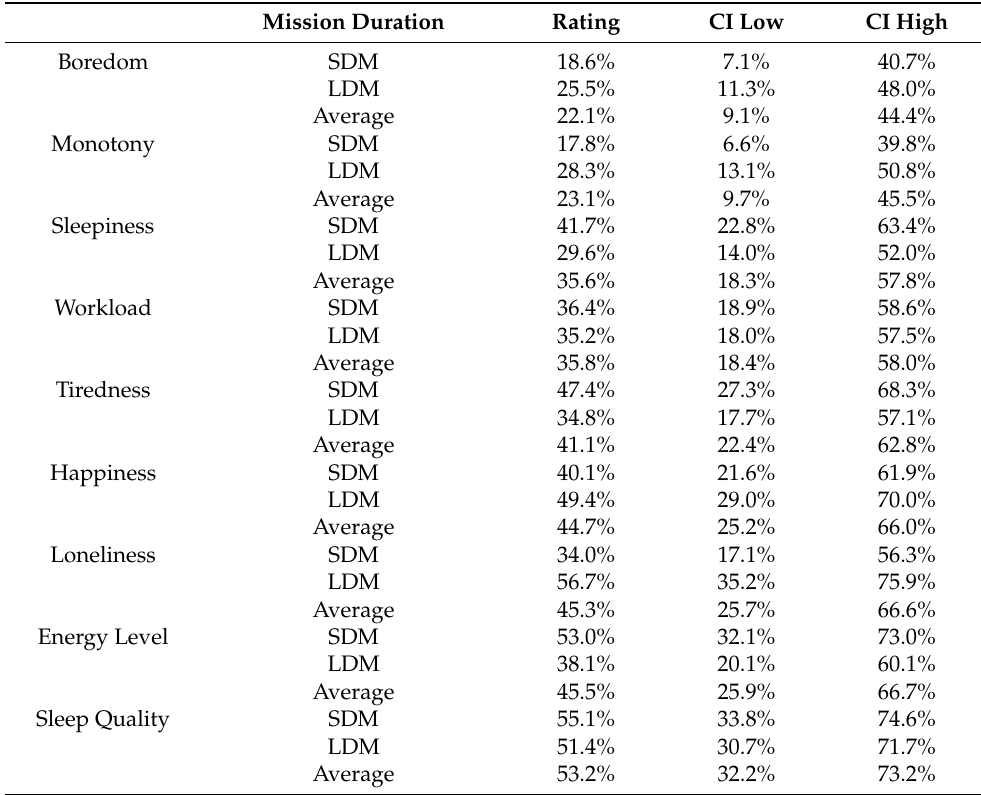
Table A1. Proportion of times an item was considered more relevant compared to all other items